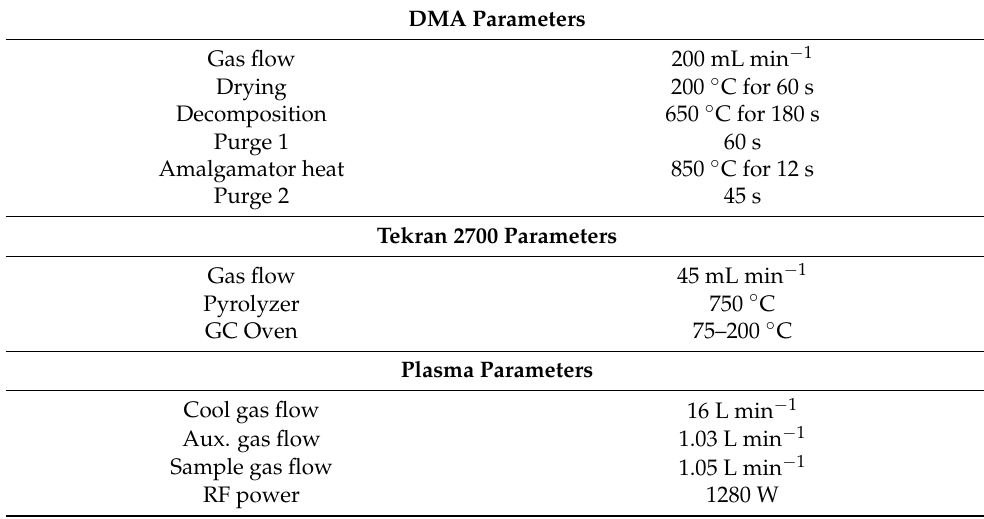
Table 1. DMA-ICP-MS instrumental